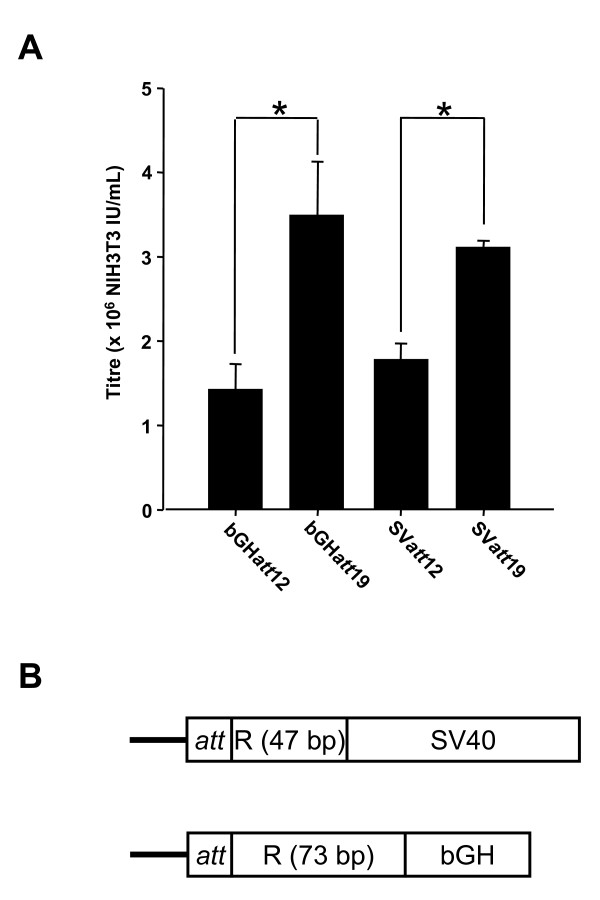
Effect of 3'U3 alterations on virus titre. (A) Titres of vectors containing either the SV40 or bGH polyadenylation sites, and either a 12 or 19 bp att sequence were compared using 0.125 ug vector per well (n = 3). bGHatt12, pHIV-1SDm2SEbGHatt12; bGHatt19, pHIV-1SDm2SEbGHatt19; SVatt12, pHIV-1SDm2SESVatt12; SVatt19, pHIV-1SDm2SESVatt19. * = P < 0.05 ANOVA on Ranks. All results are presented as Mean ± SD. (B) Schematic of 3' LTR structures. In both cases R is truncated at the 3' end, att is 12 or 19 bp in length. SV40, SV40 early polyadenylation signal; bGH, bovine growth hormone gene polyadenylation signal (see Results for details).